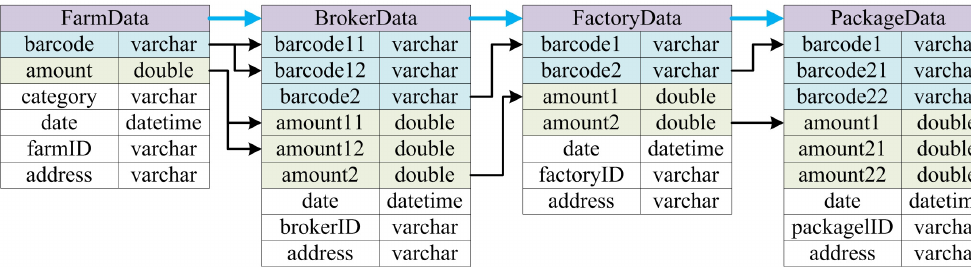
Figure 11. Data entities of quality control system for bee